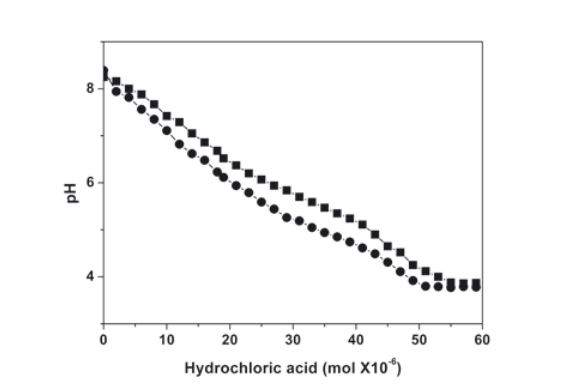
Figure 2. Potentiometric titration curve for copolymers in distilled water.The copolymer concentration was 0.5 mg mL -1 . P 30 ( ■ ), P 60 ( ● ).